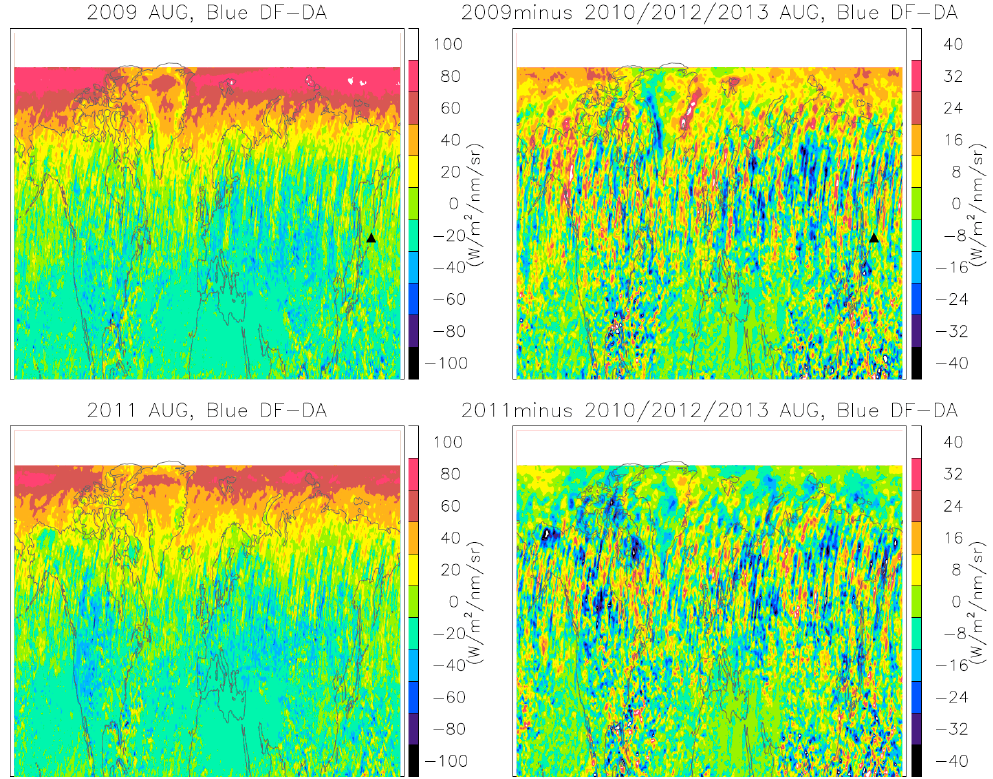
(June 2009) eruption. The August mean radiance anisotropy from 2010, 2012, and 2013 is used as the reference to highlight the anisotropy differences in the year with (2009) and without (2011) SVA impact. The MISR radiance and radiance difference units are W/m 2 /nm/sr. The striping in the maps is due to MISR sampling